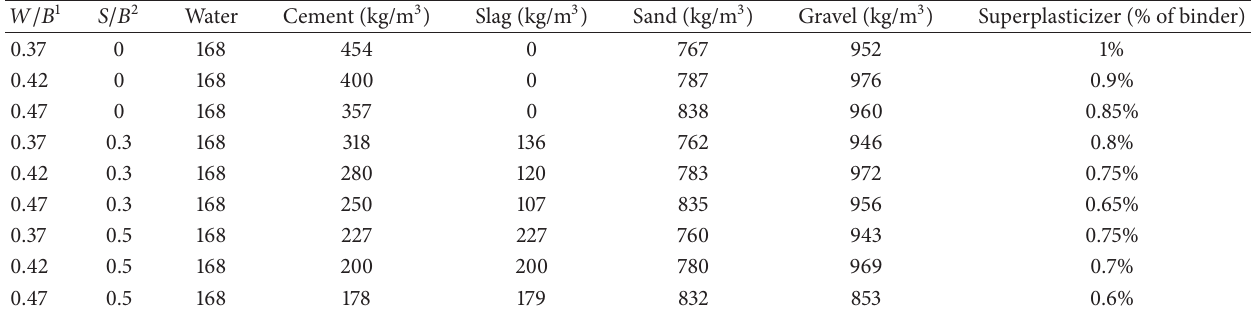
Table 2: Mixing proportions of concrete